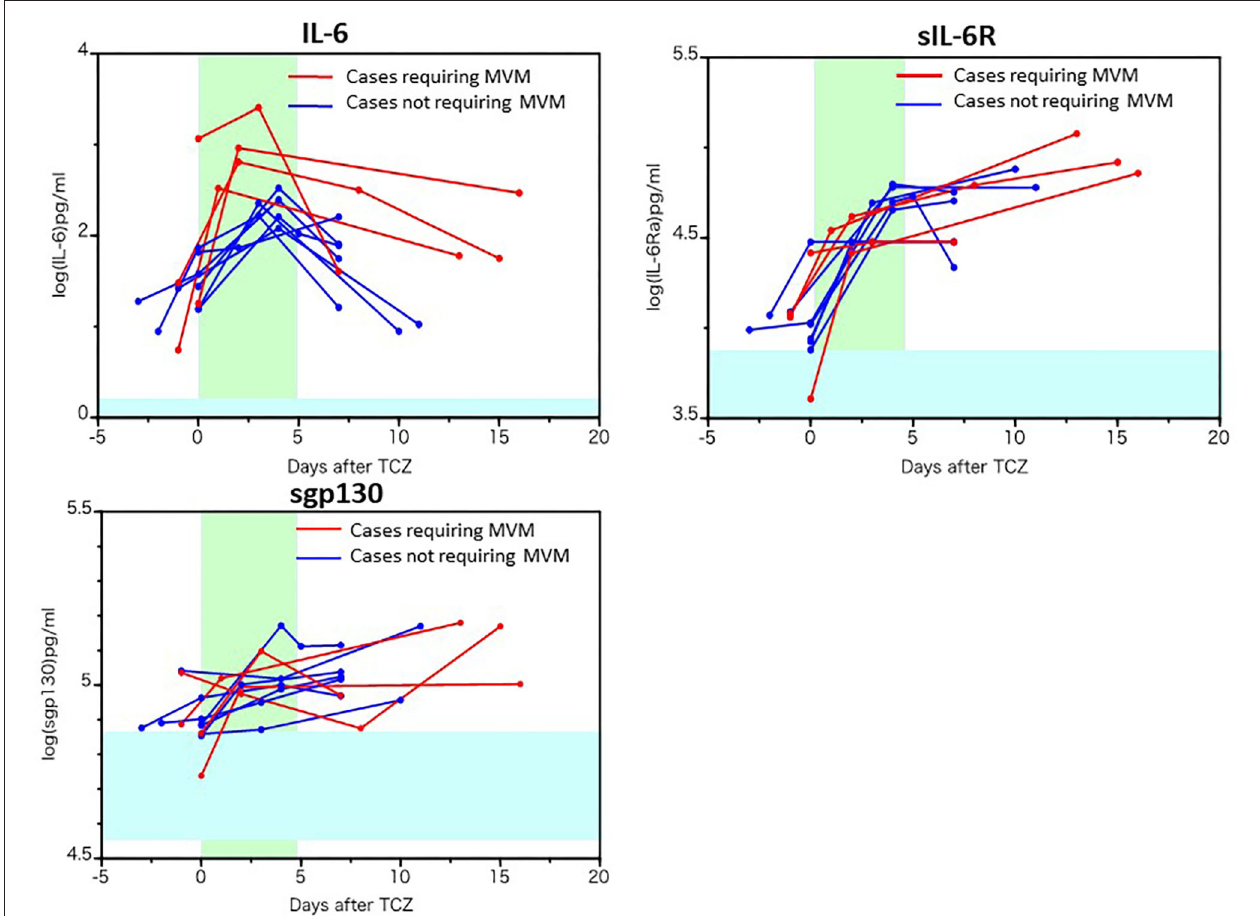
FIGURE 3 | Changes in the serum levels of IL-6, soluble IL-6 receptor, and soluble gp130 before and after tocilizumab administration. The serum levels of IL-6, soluble IL-6 receptor (sIL-6R), and soluble gp130 (sgp130) in 10 patients with COVID-19 before and after tocilizumab administration were measured using a multiplex cytokine array system. The red line represents the data of patients requiring mechanical